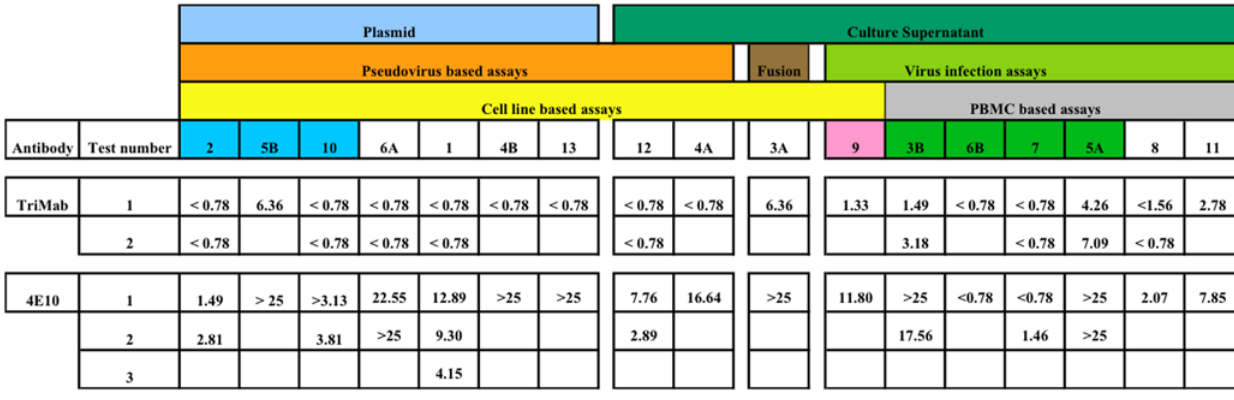
Table 2. Inter-Laboratory comparisons with TriMab a .